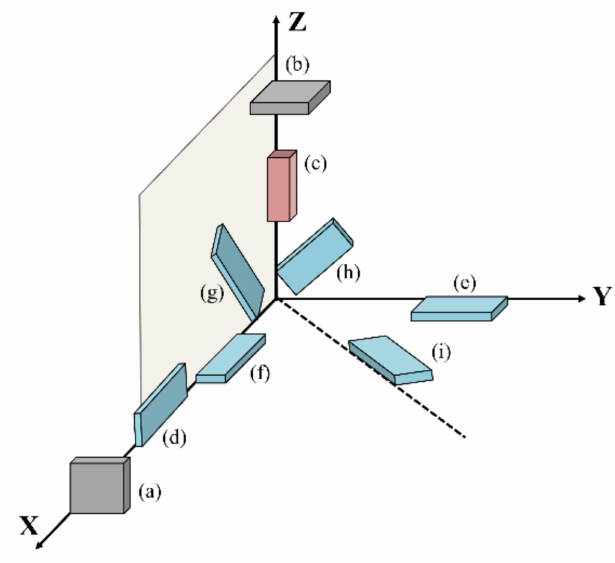
Figure 1. Schematic configuration for the evaluation of electro-elastic constants: ( a ) X-square plate; ( b ) Z-square plate; ( c ) Z bar; ( d ) YX plate; ( e ) ZY plate; ( f ) ZX plate; ( g ) YZt/ θ ( θ = 30 ◦ , 45 ◦ and 60 ◦ ); ( h ) XYt/ θ ( θ = 60 ◦ ); and ( i ) ZXt/ θ ( θ = 70 ◦ and 80 ◦ ).